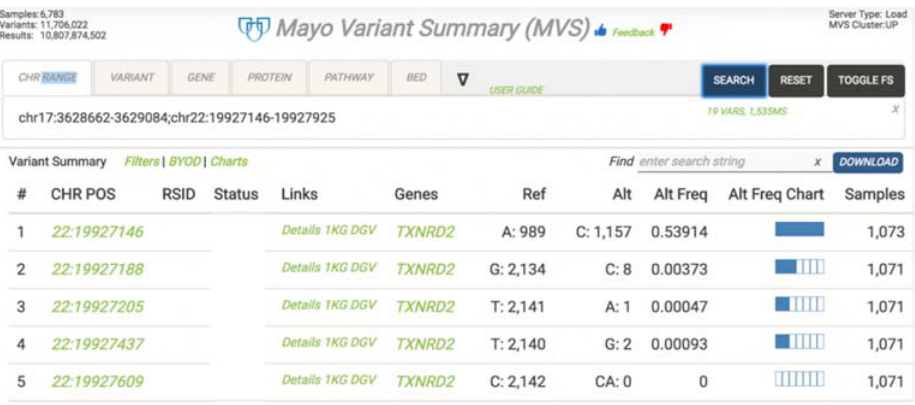
Figure 4. Mayo variant summary (MVS).